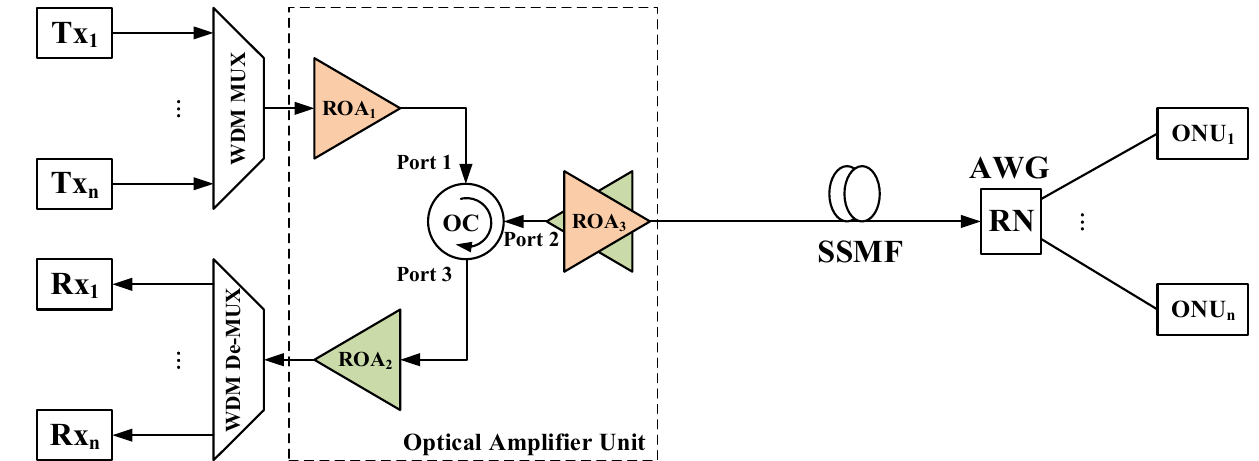
Figure 1. The proposed protection scheme for WDM-PONs based on ROAs. Tx 1 –Tx n and Rx 1 –Rx n in the OLT are transmitters and receivers, respectively. All